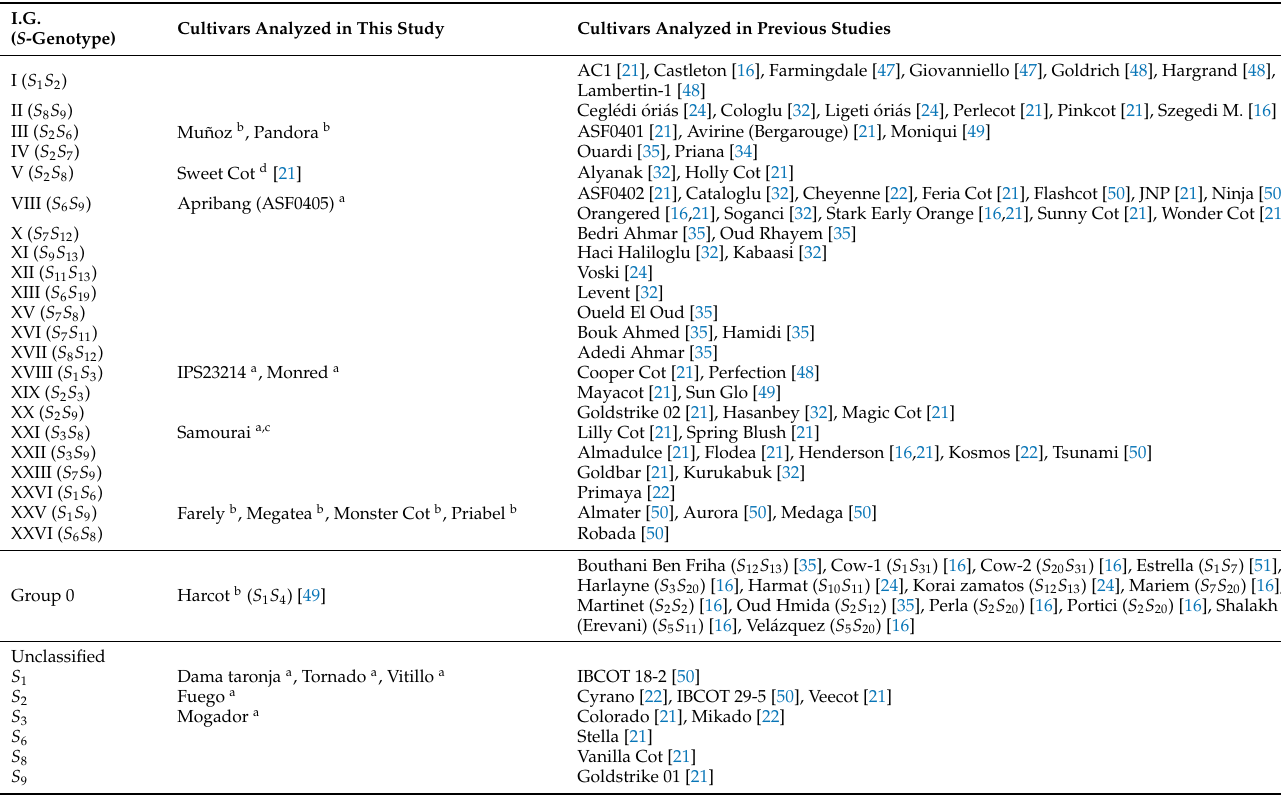
Table 1. Incompatibility group (I.G.) and S -genotype of 103 apricot